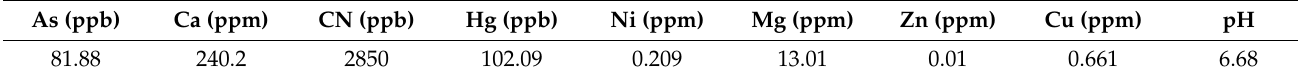
Table 1. Specifications of the effluent prepared for use in EC